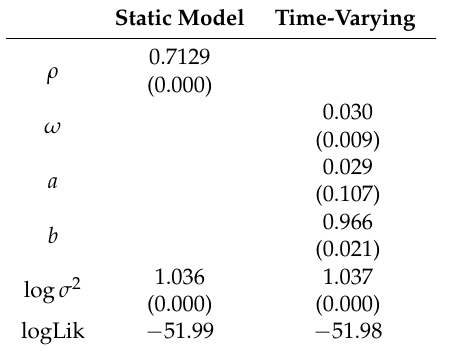
Table A3. The spatial model results. Estimated parameters and their robust (sandwich) standard errors in parentheses, for the static spatial lag model and the time-varying spatial model, based on Student’s t distributed errors. W matrix = Spearman correlation matrix of stock